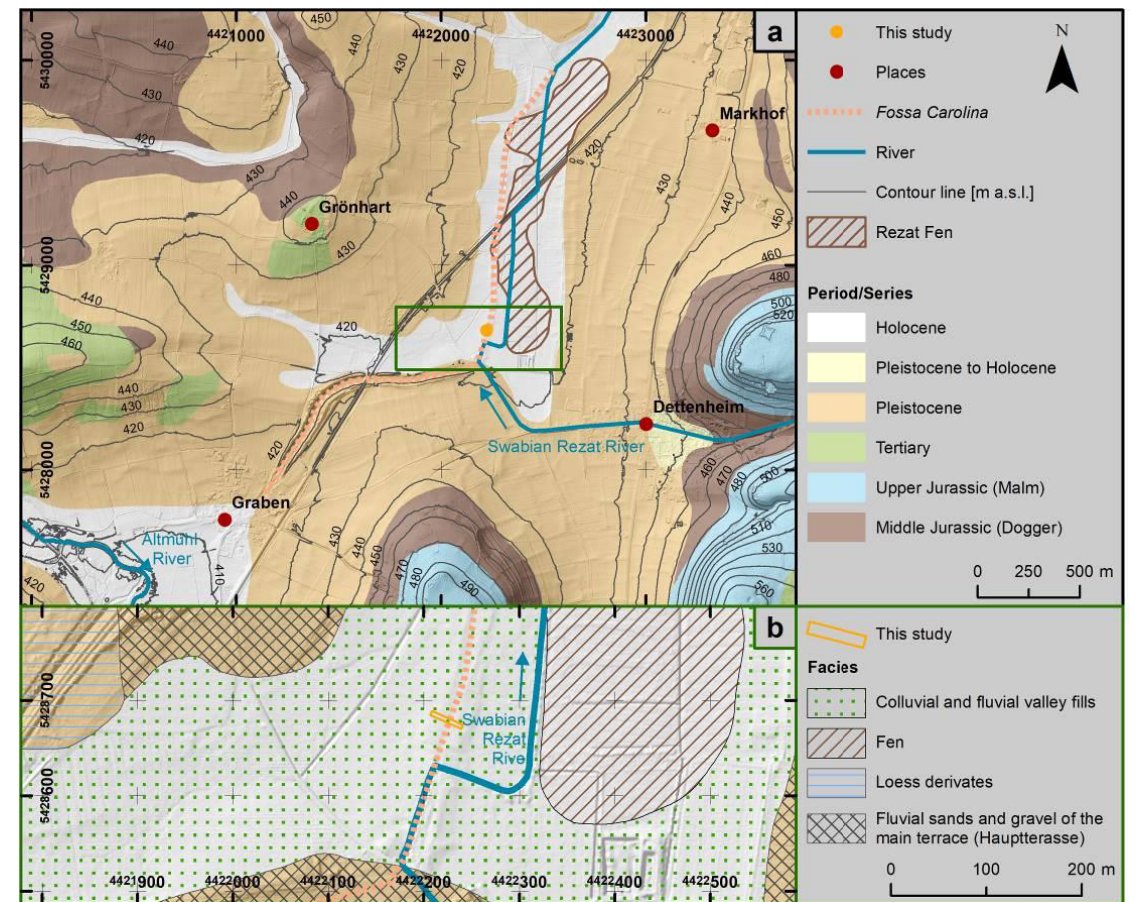
Figure 3. ( a ) Regional and ( b ) local-scale geological setting in the area of the Fossa Carolina. (Database: drawn after Berger and Schmidt-Kaler [44] and Schmidt-Kaler [45], LiDAR data are provided by Bavarian Land Surveying Office).